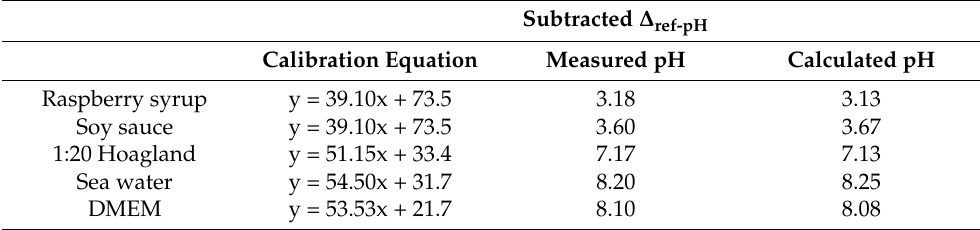
Table 1. Data obtained from the calibration plots of both salicylic acid and flavanone-based electrodes in raspberry syrup and soy sauce. Comparison of the glass electrode measured pH and calculated one based on the calibration equation is presented for each solution. Subtracted data are shown as